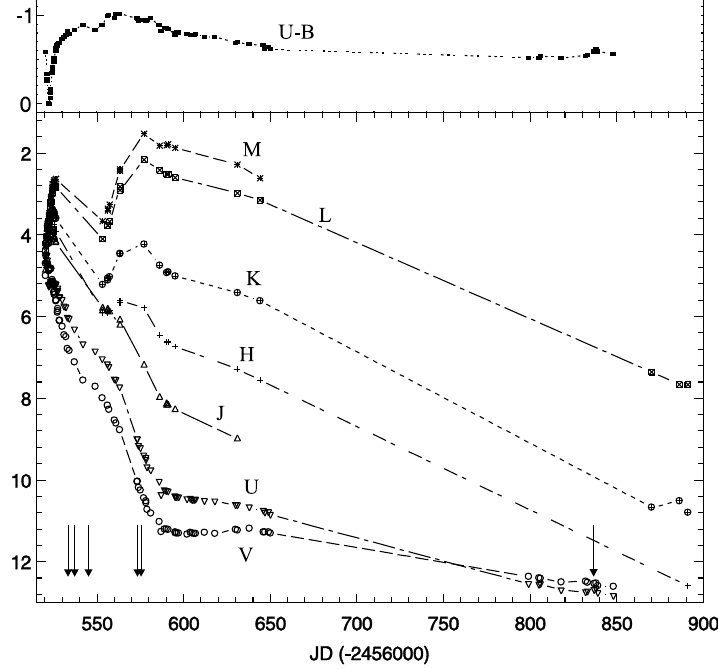
Fig. 1. The UVJHKLM light curves and U (cid:0) B color curve of Nova Delphini